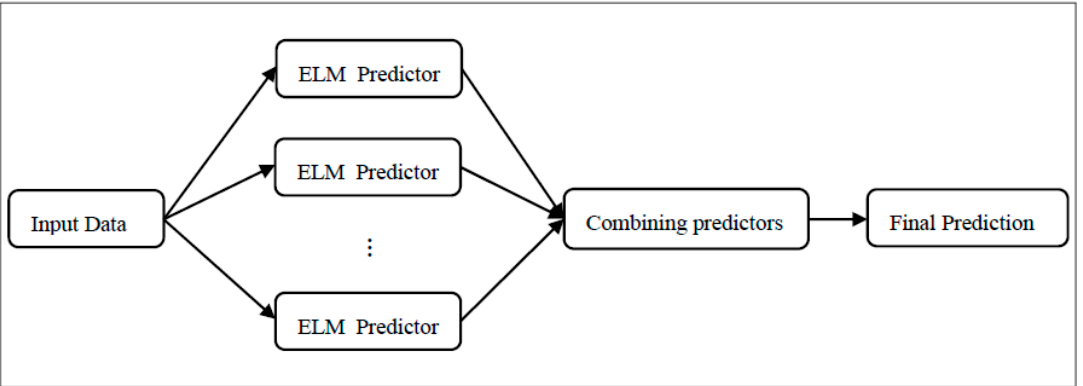
ffi c prediction using ensemble Figure 3. Proposed Framework of traffic prediction using ensemble method. Figure 3. Proposed Framework of tra